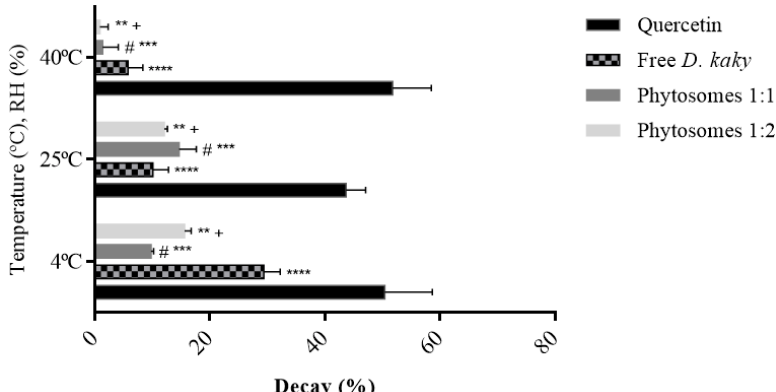
Figure 4. The percentage of decay of antioxidant activity of the free extract, phytosomes (molar ratio 1:2 and 1:1) and quercetin, in the conditions of temperature and humidity established (%DPPHt 0 –%DPPHt 6 ). **** p < 0.0001 vs. quercetin, # p < 0.0001 vs. quercetin, ** p < 0.0001 vs. quercetin, *** p < 0.0001 vs. free extract, + p < 0.0001 vs. free extract.